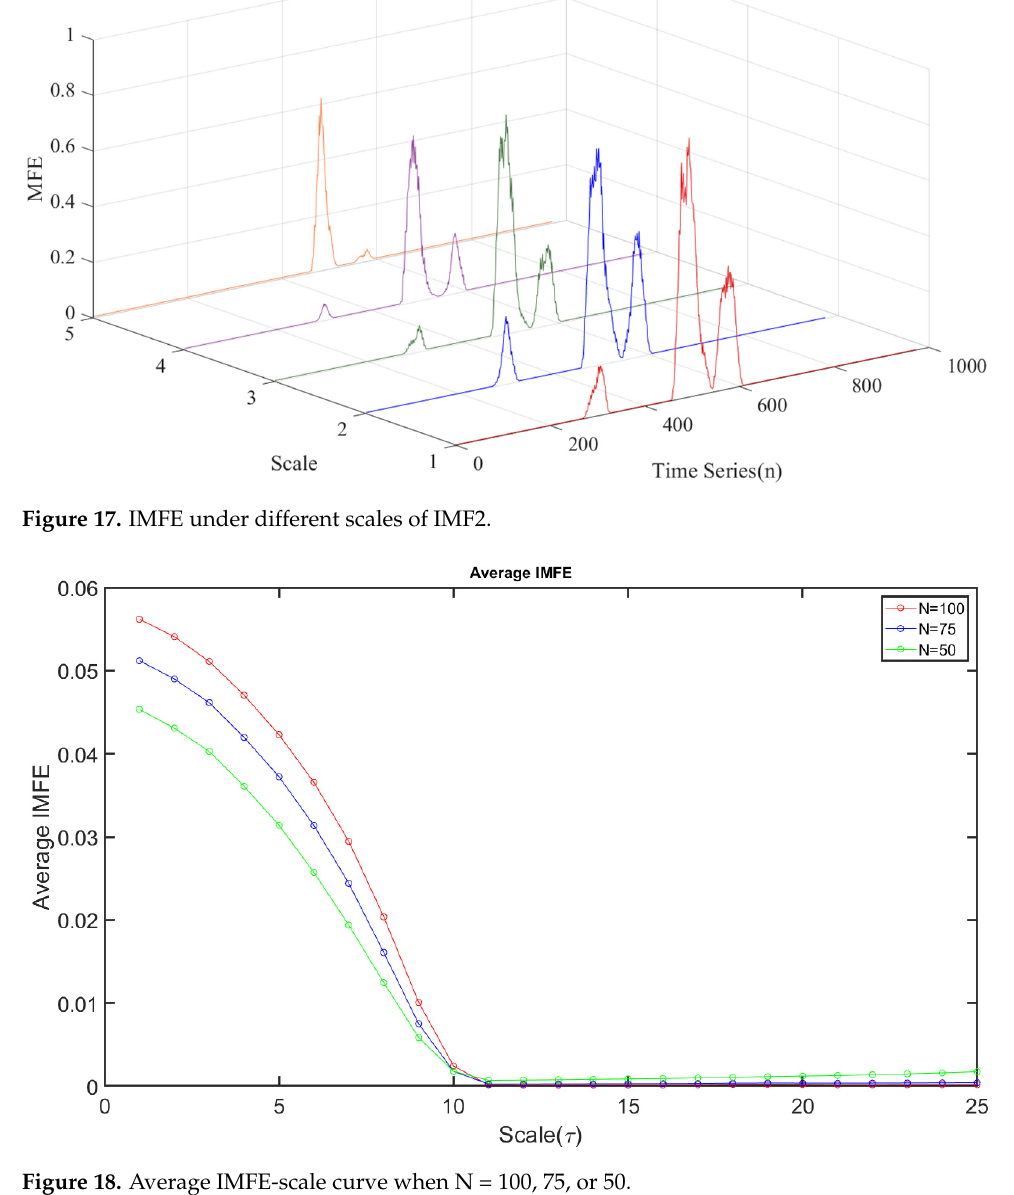
Figure 18. Average IMFE-scale curve when N = 100, 75, or 50.